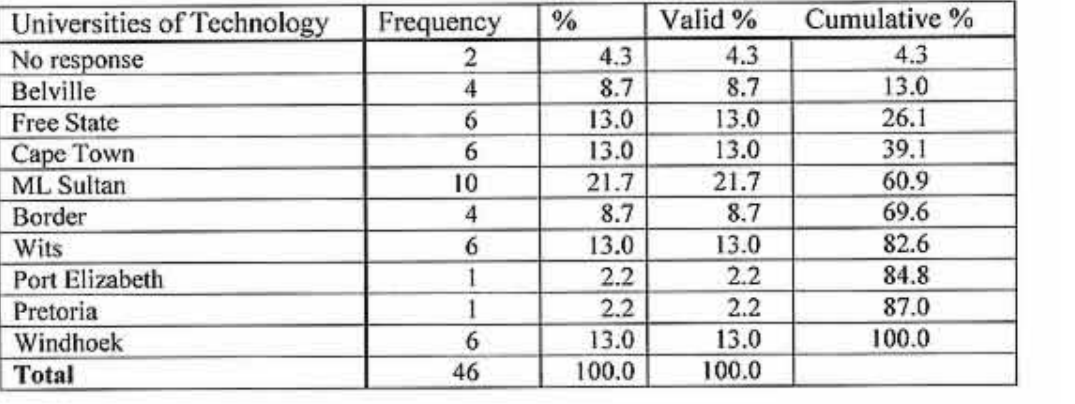
Table 1 Geographic demarcation: UoTs in SA and &